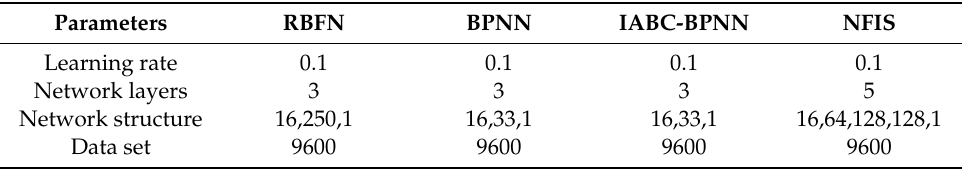
Table 3. The parameters setting of the compared